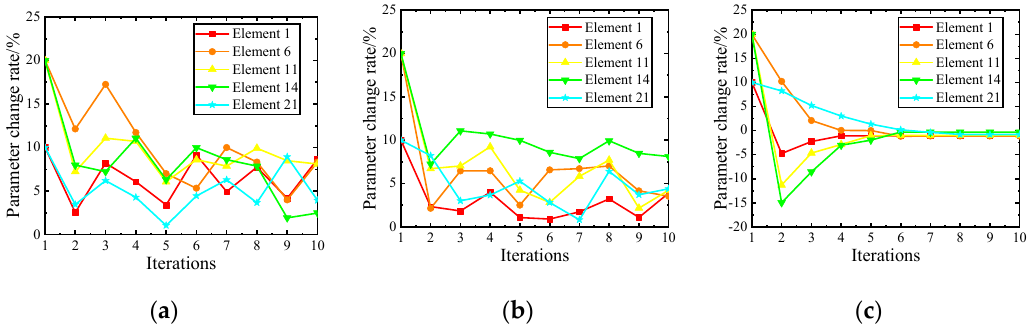
Figure 8. Comparison of elastic modulus updating results of three cases: ( a ) Case 1; ( b ) Case 2; ( c ) Case 3.